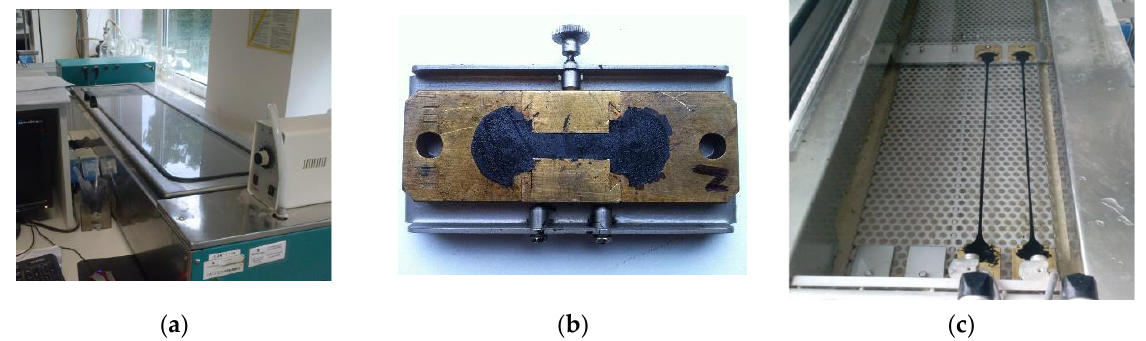
Figure 6. Force ductility test: ( a ) ductilometer, ( b ) test sample, ( c ) stretching of samples.